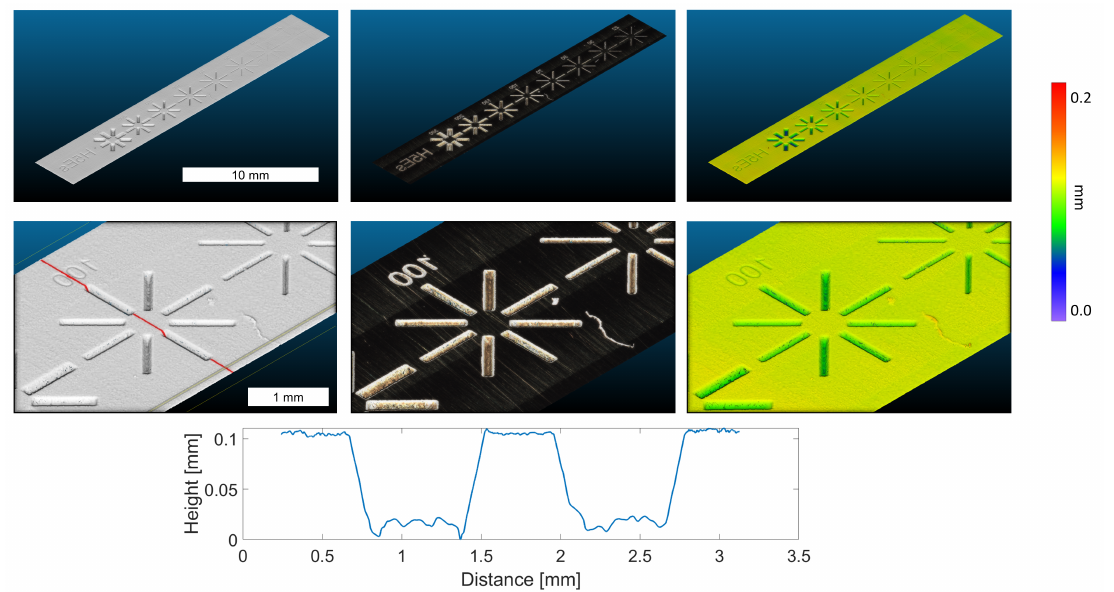
Figure 9. The results of our proposed microscopic imaging setup scanning a print plate generated by using laser cutting. The laser cuts were from 350 µ m down to 25 µ m in depth. We chose the 100 µ m laser cut to measure, as all structures were in our corresponding DOF. As can be seen, despite having only minimal texture, our system could still recover the depth structure. In the lower part of the image, a zoom in on the 100 µ m cut is shown with its corresponding depth profile (red